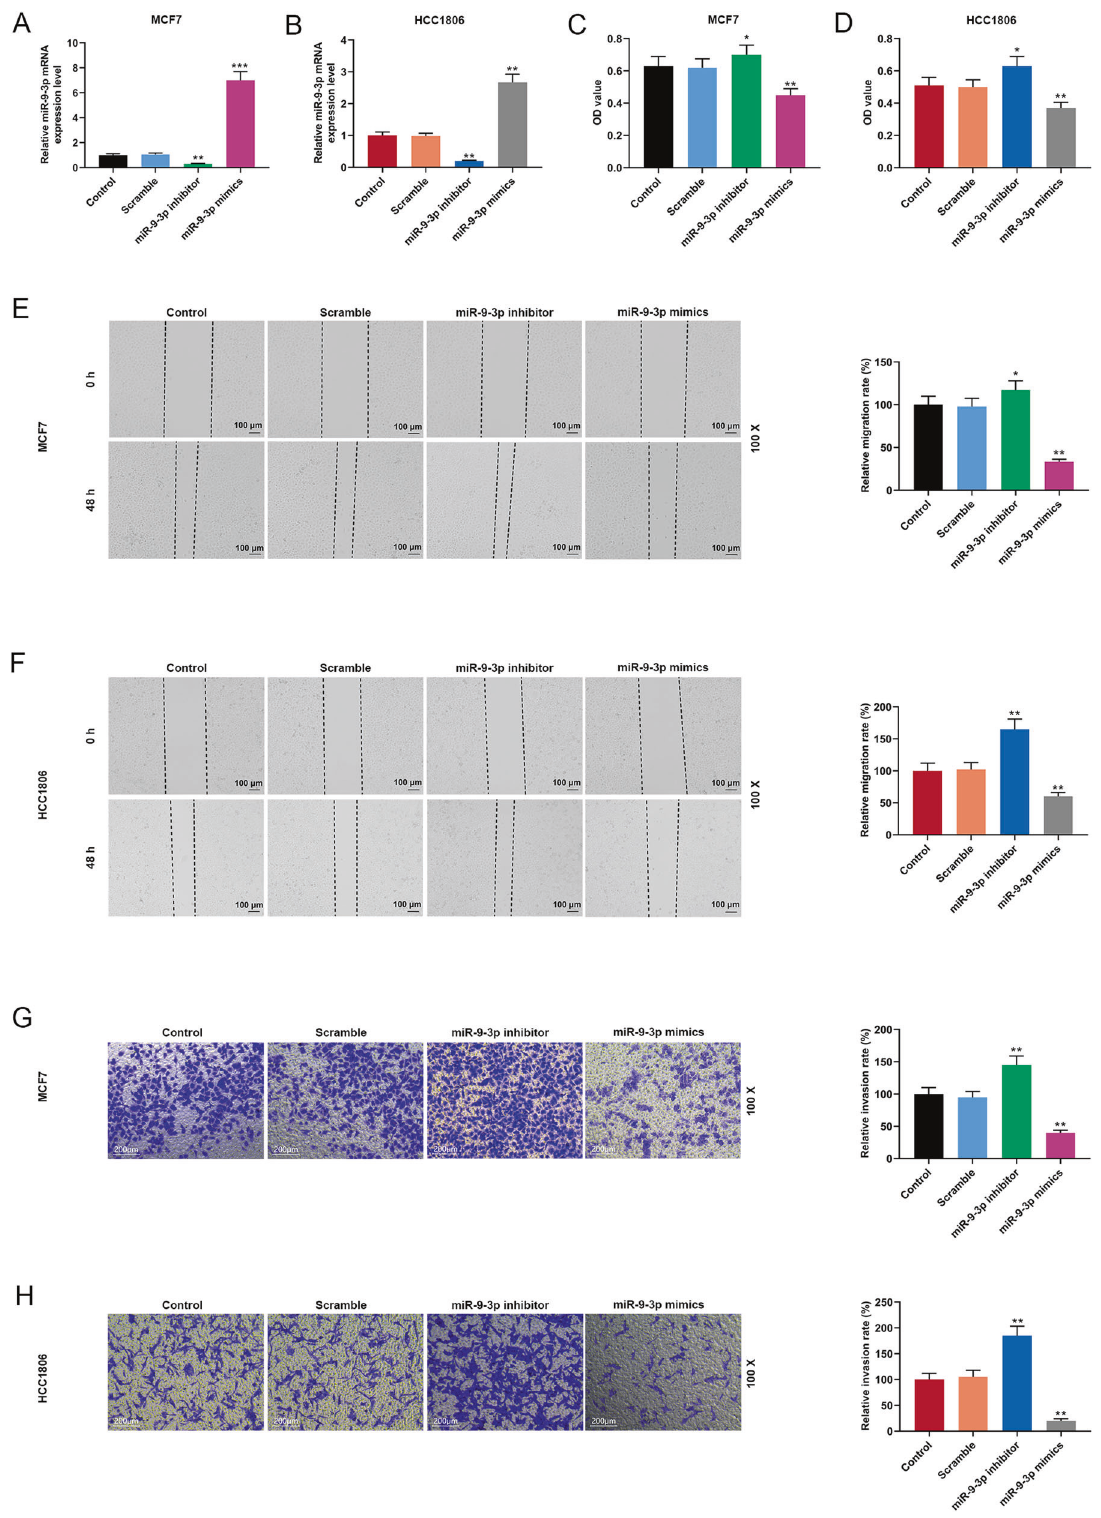
Fig. 6 MiR-9-3p affects the viability, migration, and proliferation of breast cancer cells. A QRT-PCR was used to detect the expression of miR-9-3p in MCF7 cell transfected with miR-9-3p inhibitor and mimics. B QRT-PCR was used to detect the expression of miR-9-3p in HCC1806 cells transfected with miR-9-3p inhibitor and mimics. C The viability of MCF7 cells was measured by CCK-8. D The viability of HCC1806 cells was measured by CCK-8. E Wound scratch assay was used to test the migration ability of transfected miR-9-3p inhibitor and mimics MCF7 cells. F Wound scratch assay was used to determine the migration ability of transfected miR-9-3p inhibitor and mimics HCC1806 cells. G Transwell was used to examine the effects of miR-9-3p inhibitor and mimics on MCF7 cell invasion. H Transwell examined the effects of miR- 9-3p inhibitor and mimics on HCC1806 cell invasion. ( n = 3, ** P < 0.001, vs. Control). QRT-PCR quantitative real-time polymerase chain reaction, CCK-8 cell counting kit-8. Cell Death and Disease (2021)